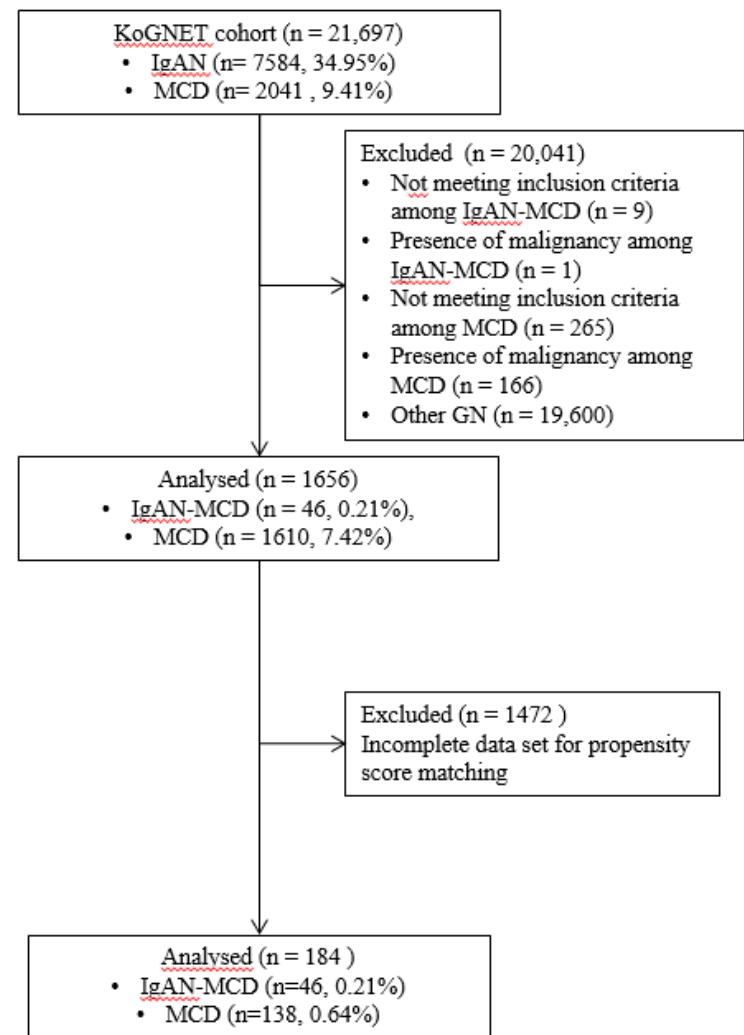
Figure 1. Flow diagram for patient selection and preparation of the propensity score-matched model.